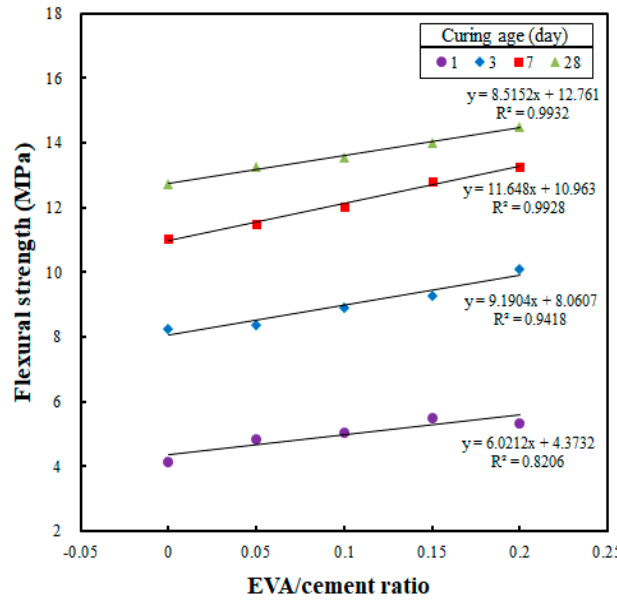
Figure 8. Relationship between EVA / cement ratios and flexural strengths for cast specimens at different curing ages.